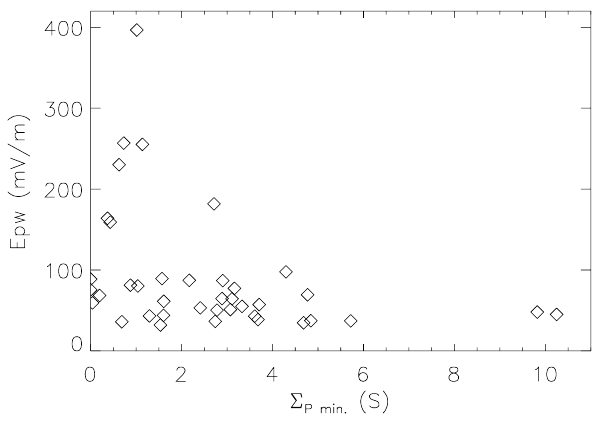
Fig. 8. Distribution of the SAID electric field peak intensity versus the difference in CGLat between the SAID event location and the corresponding conductivity minimum location ( 1CGLat e − 6